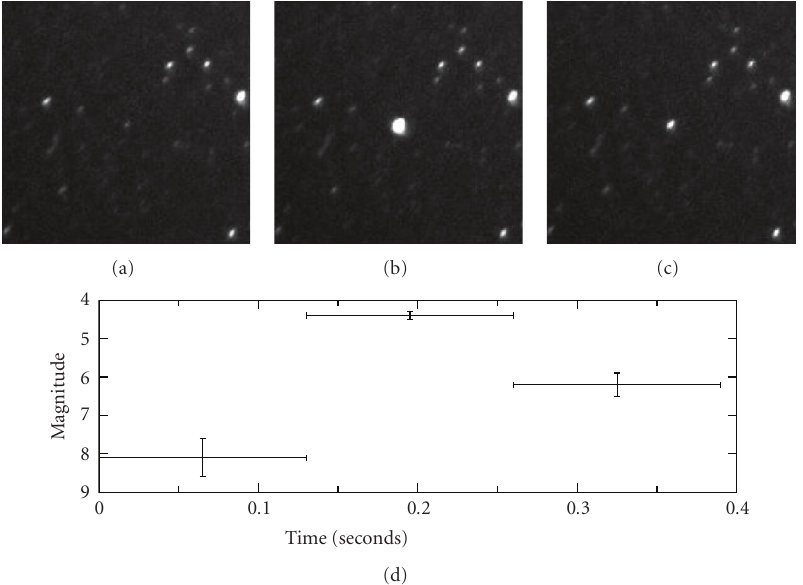
Figure 3: Example of a short satellite flare detected by the camera. Total length of the event is 0.4 sec (seen on 3 successive frames).